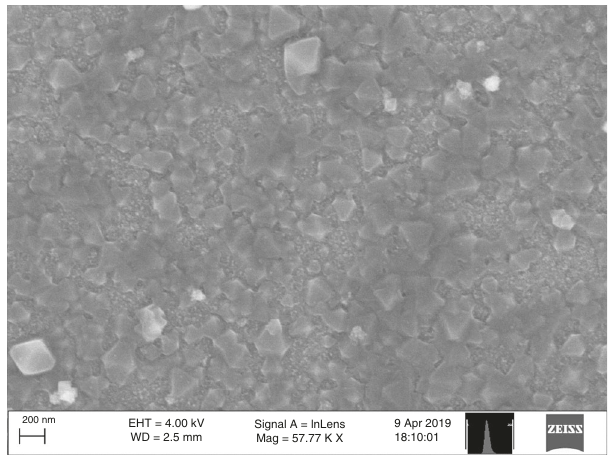
Fig. 3 Scanning electron microscopy (SEM) of Zr(NDI) ∣ TiO 2 @GaP. SEM image showing octahedra typical of the PIZOF-type MOF. Corresponding characterization for Si substrates can be found in the Supplementary Information.